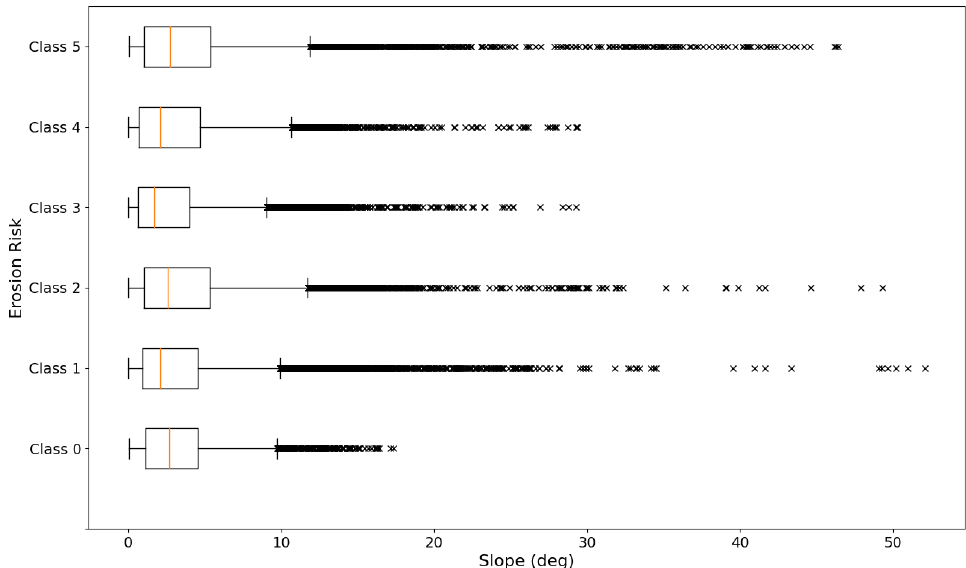
Figure 6. The slope distribution across all regions in the training dataset, separated by soil erosion risk class.